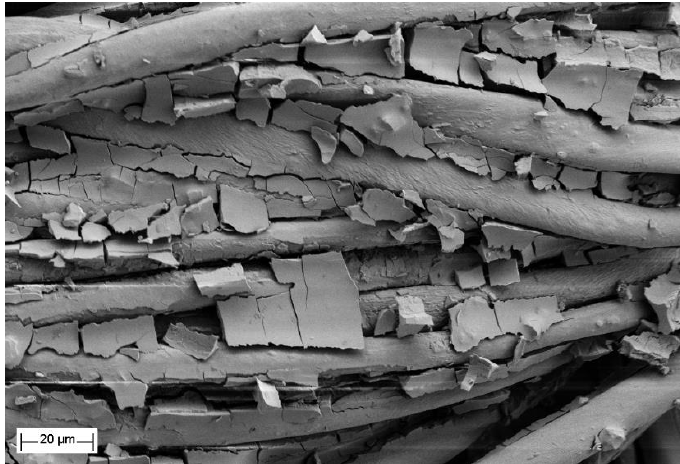
Figure 7. SEM-FEG images of textiles coated by three-layer of blue Ir@SiO 2 system after 10 days of washing test in static condition.